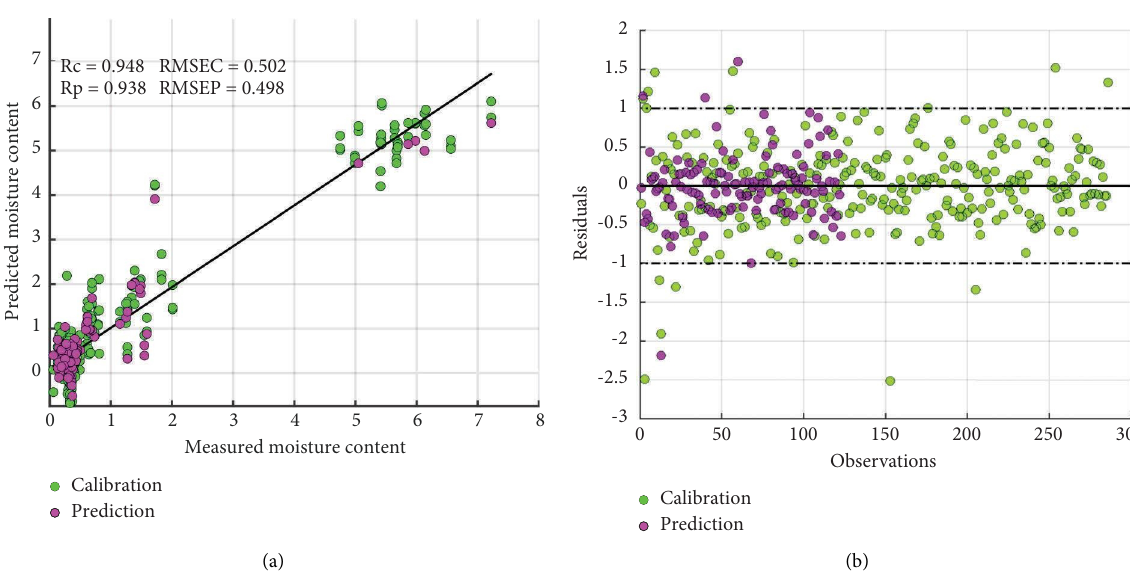
Figure 2: SGD1-PLS score plot of measured versus predicted moisture content (a) and residuals versus samples